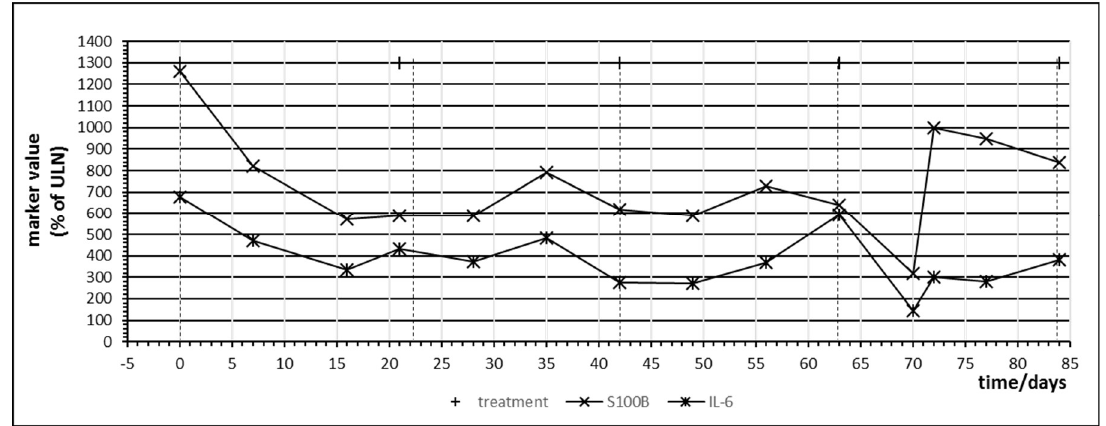
Figure 5. Time course of immune and tumor markers during checkpoint inhibitor treatment starting at day 0. Patient no. 6, first four cycles of pembrolizumab.